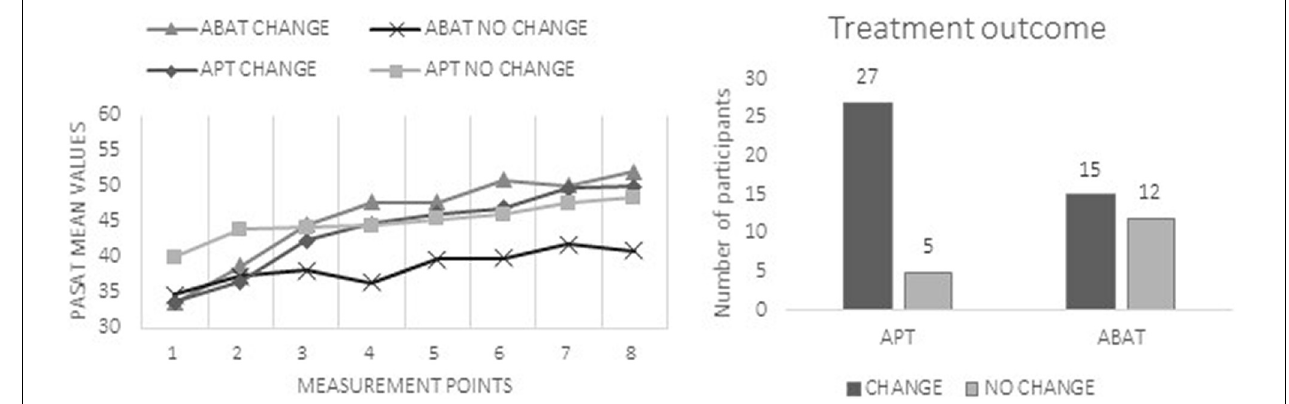
FIGURE 1 | The left chart presents mean scores of the Paced Auditory Serial Addition Test (PASAT) at each measurement point. These data were published earlier (Markovic et al., 2020) and are enclosed to illustrate the different improvement patterns in performance during the study. The right chart shows the distribution of patients in the CHANGE vs. NO CHANGE groups separated according to treatment groups (APT, Attention Process Training; ABAT, Activity-Based Attention Training).